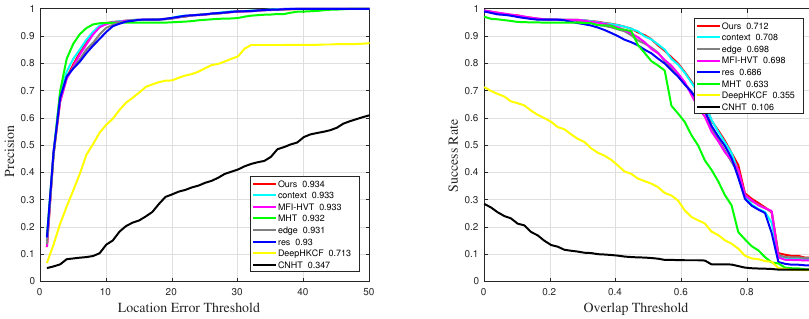
Figure 20. Precision and success rate under SV